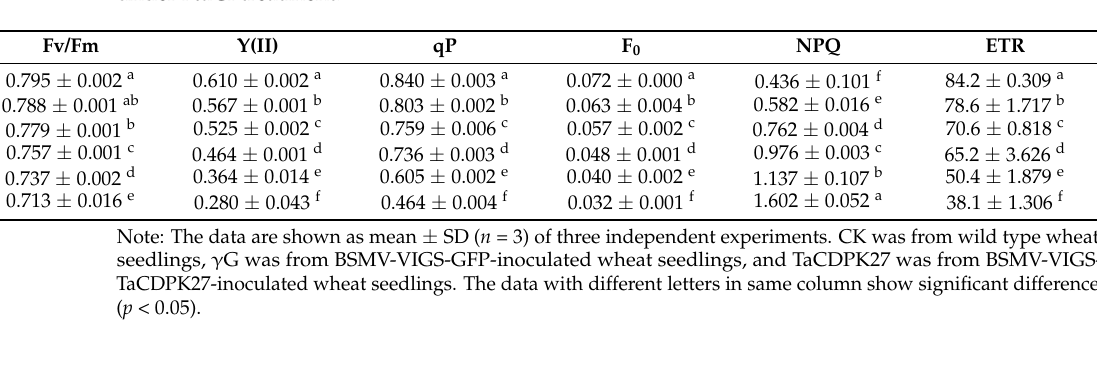
Table 2. The effect of TaCDPK27 silencing on chlorophyll fluorescence parameters of wheat seedlings under NaCl